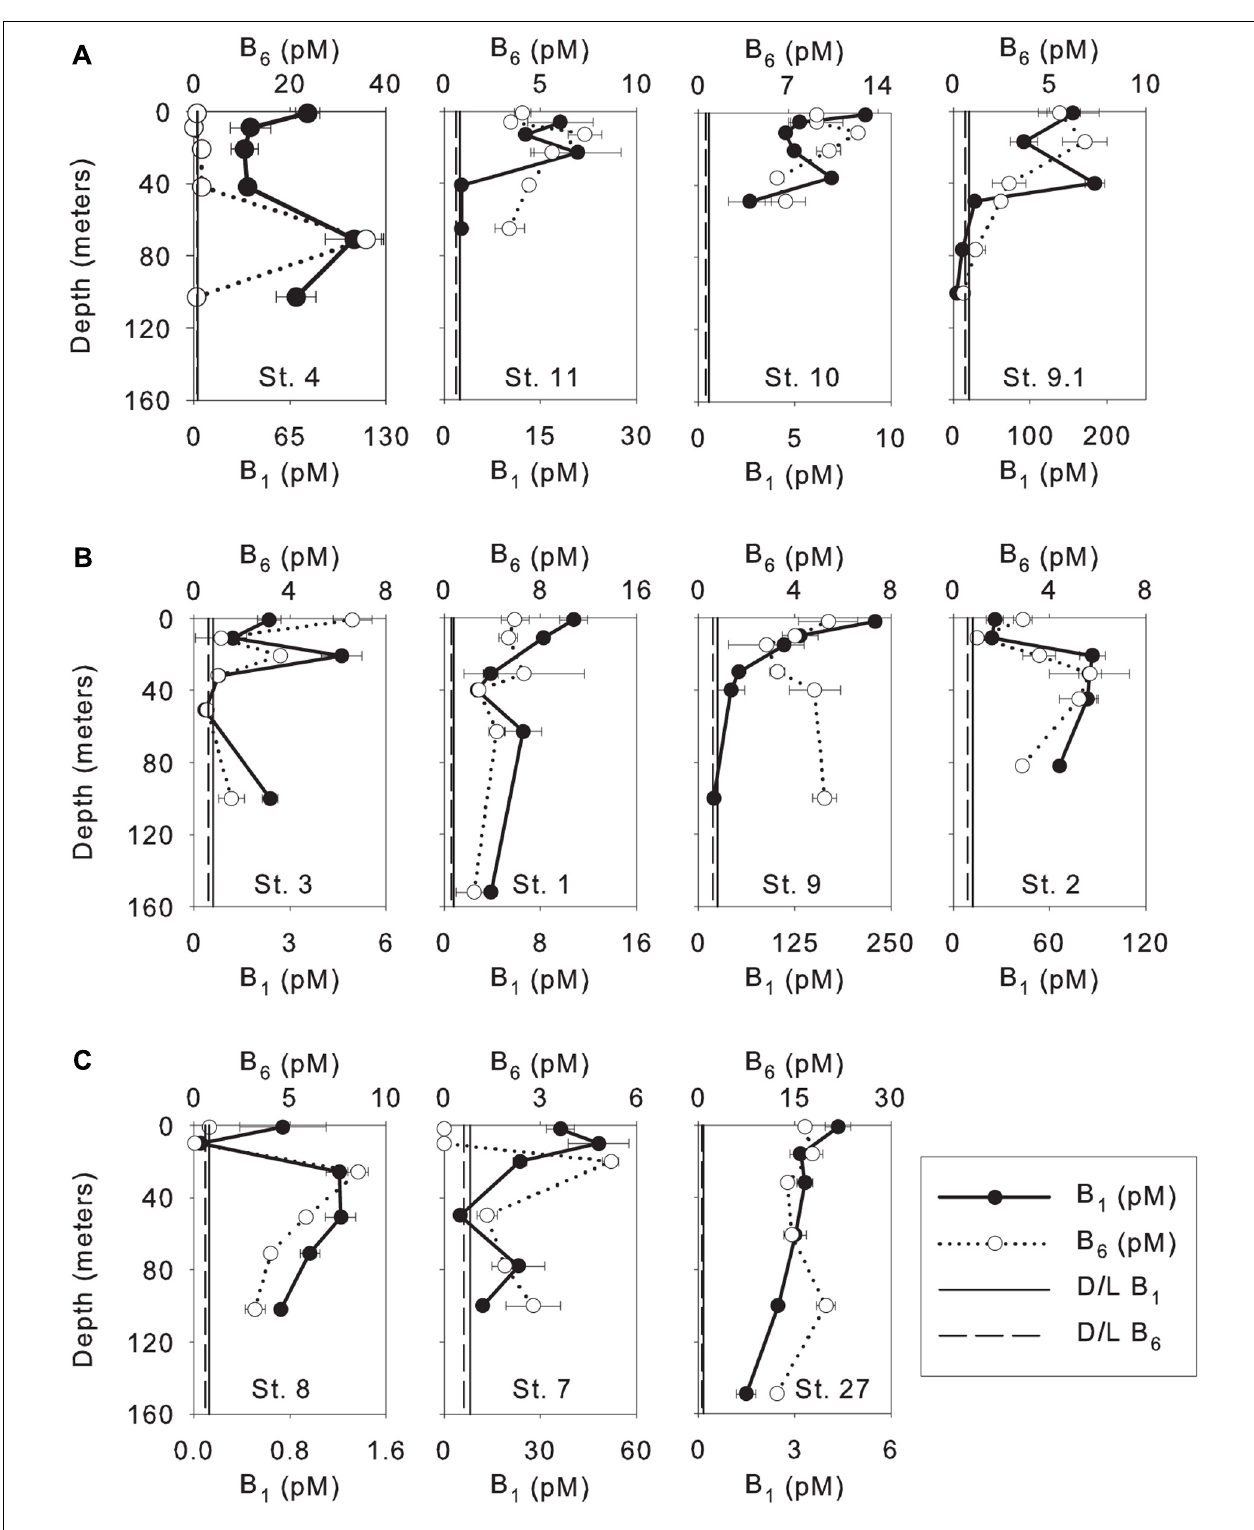
FIGURE 2 | Depth profiles of dissolved vitamins (B 1 and B 6 ) measured in theWTNA Ocean; (A) low-salinity stations; (B) mesohaline stations; (C) oceanic/open ocean stations. Stations are ordered by sea surface salinity (SSS) moving from the lowest to highest SSS. Surface concentration of